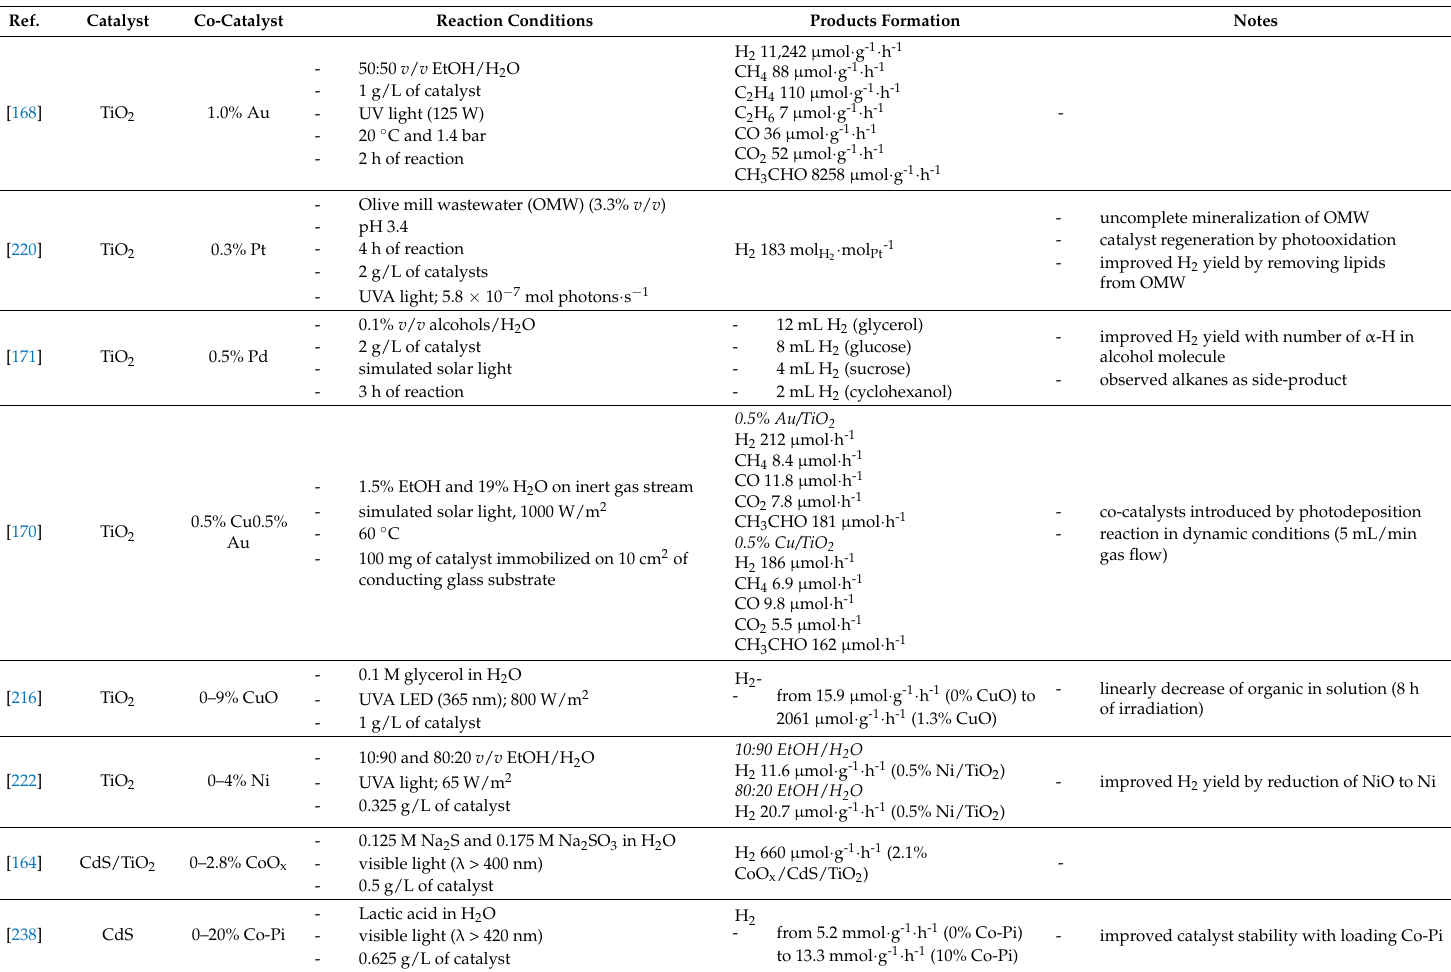
Table 4. Summary of some used photocatalysts for biomass